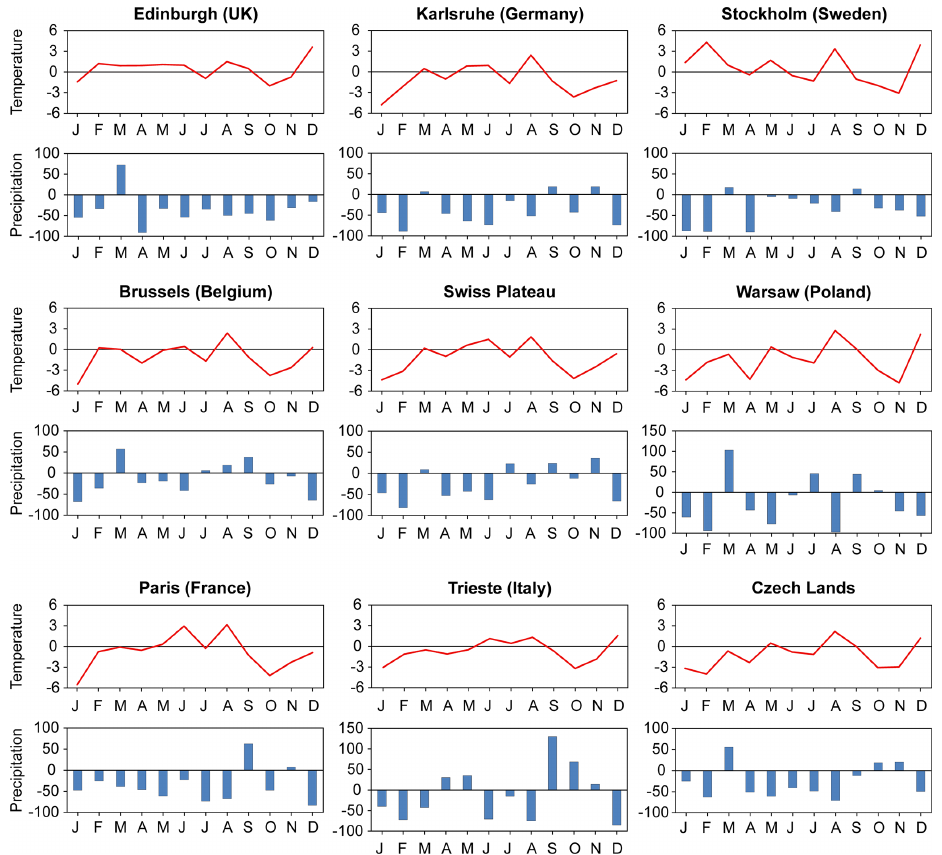
Figure 5. Annual variation in air temperature and precipitation in 1842 for selected European meteorological stations and regions. Tem- peratures are expressed as deviations from the 1961–1990 reference period and precipitation totals as percentages of corresponding 30-year